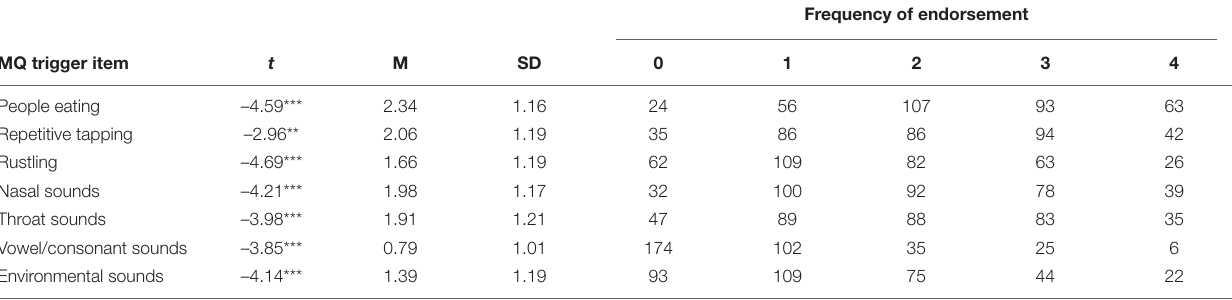
TABLE 4 | Trigger items endorsed on the trigger subscale of the misophonia questionnaire (MQ).